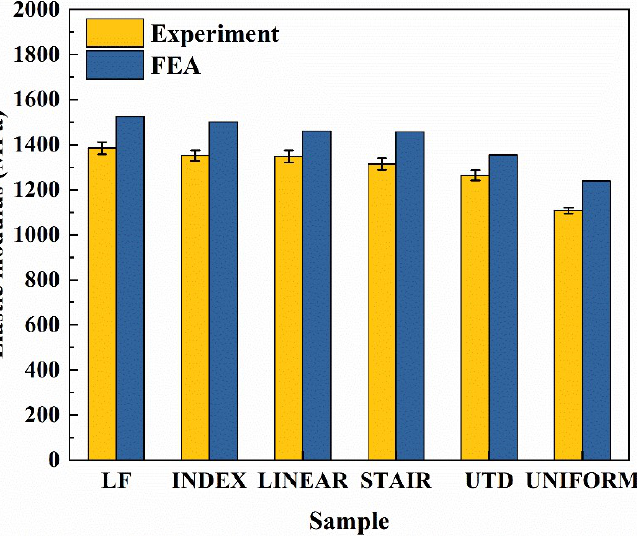
Figure 10. Comparison of elastic modulus between experimental data and finite element analysis.